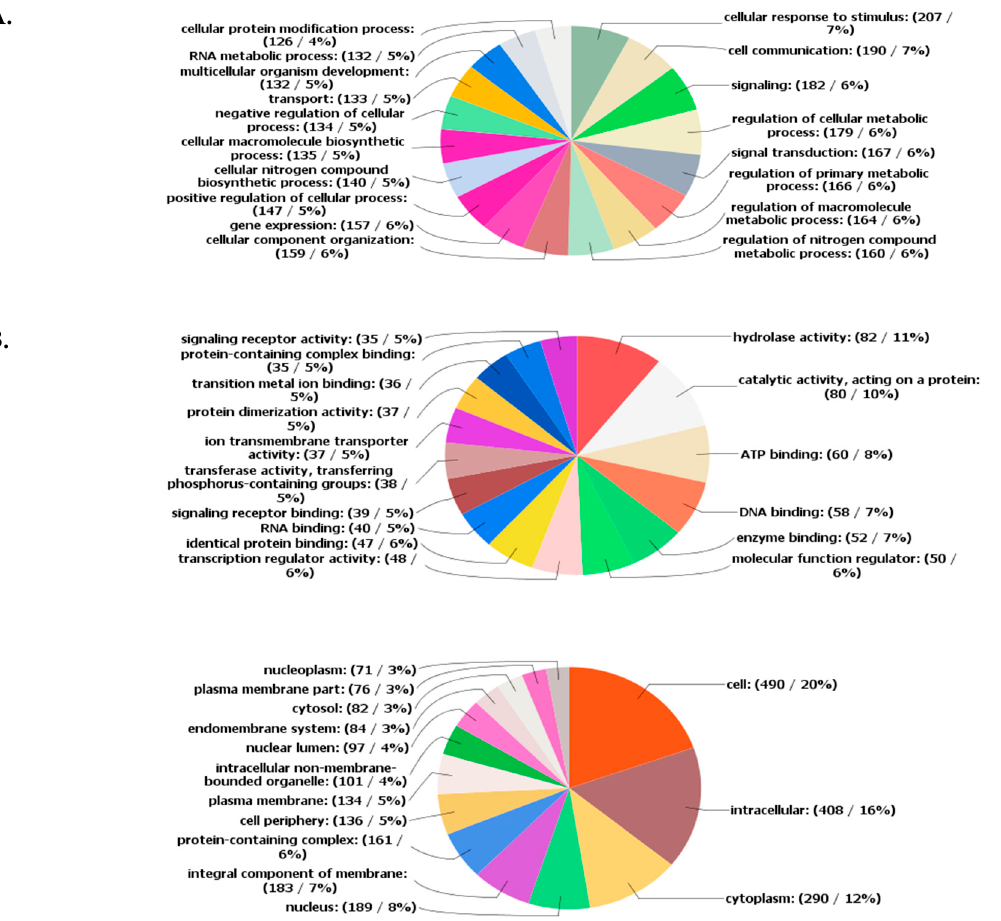
Figure 1. Gene ontology (GO) of enriched terms associated with candidate genes (CGs) in boar spermatozoa. A . Biological process categories; B . molecular function categories; C . cellular component categories. The values in the parenthesis indicate the number of inputs and the percentage of CGs enriched to the category.